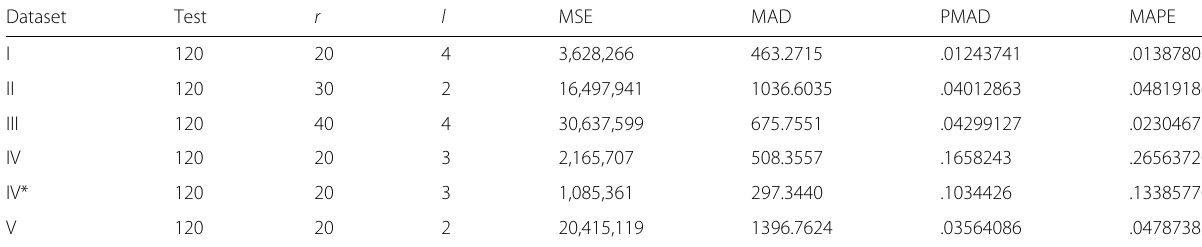
Table 3 Parameters of selected models and prediction accuracy metrics of these selected models, where IV* indicates the rolling approach for dataset IV